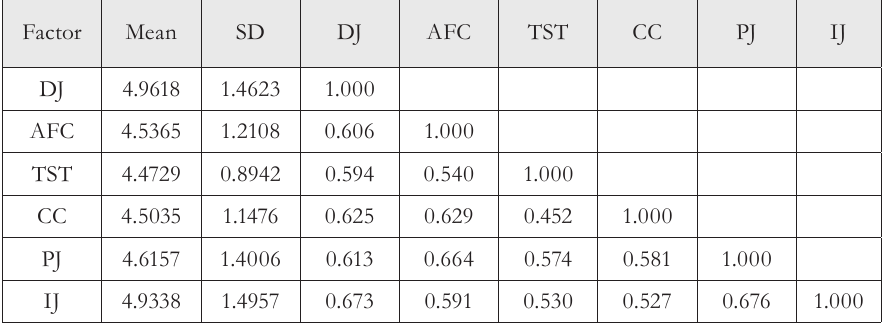
Tab. 5 - Mean, standard deviation and correlation matrix. Source: Authors